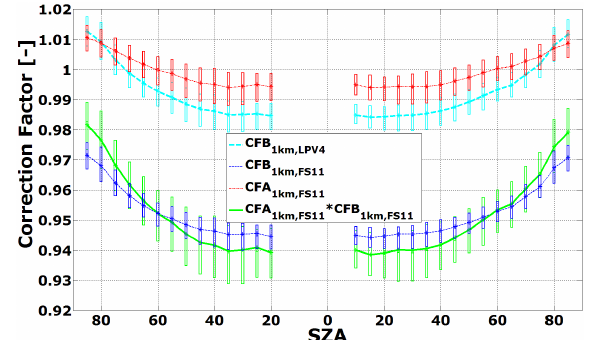
Figure 4. Mean behavior of correction factors (for case described in Sect. 3.1) CFB 1km , LPV4 for LPV4, CFB 1km,FS11 , CFA 1km,FS11 and the total correction product CFA 1km,FS11 · CFB 1km , FS11 for FS11 dependent on SZA. Bars display 68.3% of all data points.